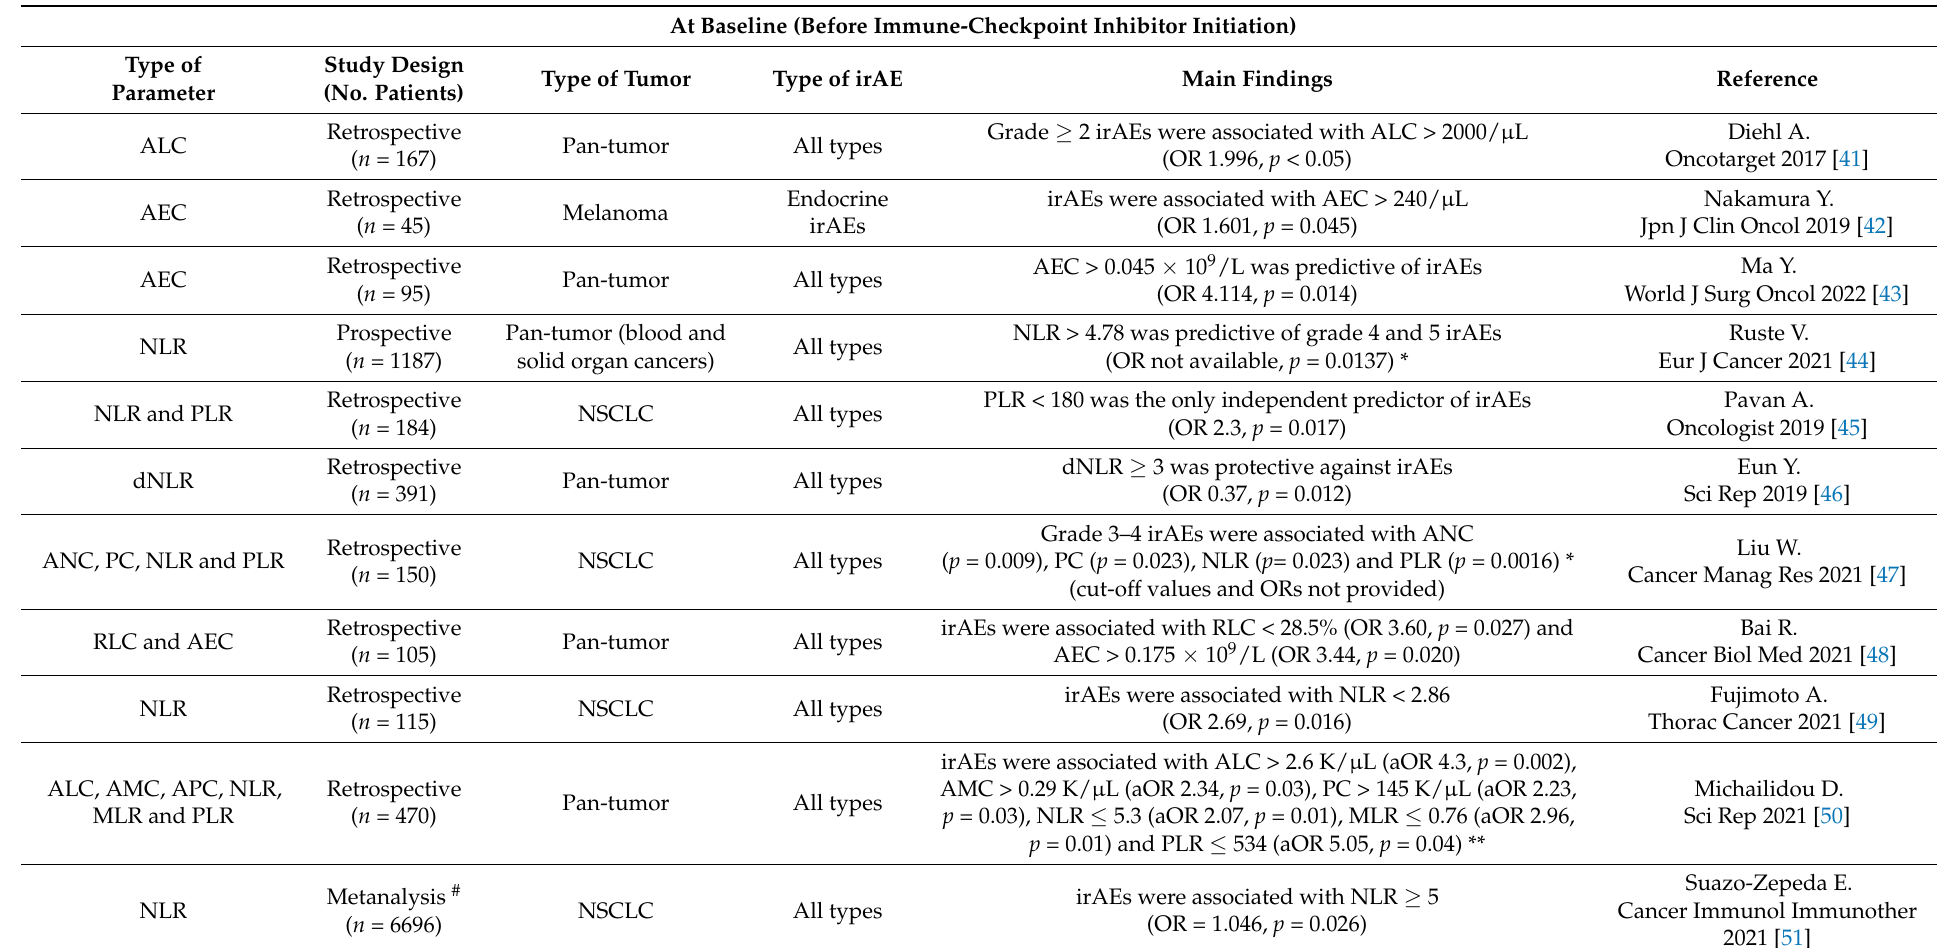
Table 2. Summary of studies on the clinical use of blood cell counts and ratios as predictive biomarkers for immune-related adverse events. At Baseline (Before Immune-Checkpoint Inhibitor